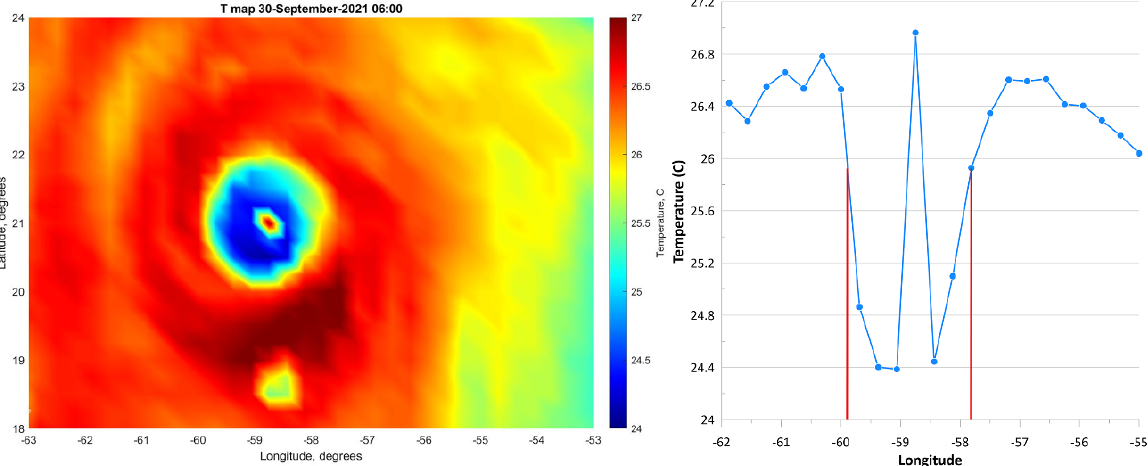
Figure 4. Left panel—bead instability observed during the auroral substorm on 21 December 2015 [14]; right panel—bead structure observed in the left part of the ACP distribution within the blue circle, seen as the chain of yellow spots at Hurricane Sam’s periphery on 26 September 2021.